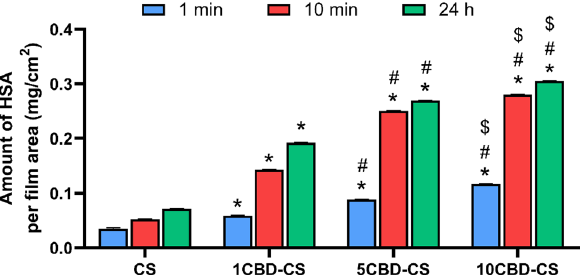
Figure 6. Amount of bounded human serum albumin at the surface of the obtained films, where 1, 5, 10CBD-CS corresponds to the weight ratio of 1, 5 or 10% of cannabidiol oil (CBD) to chitosan (CS). *, #, $ indicate p < 0.05 when compared to the corresponding CS, 1CBD-CS and 5CBD-CS,